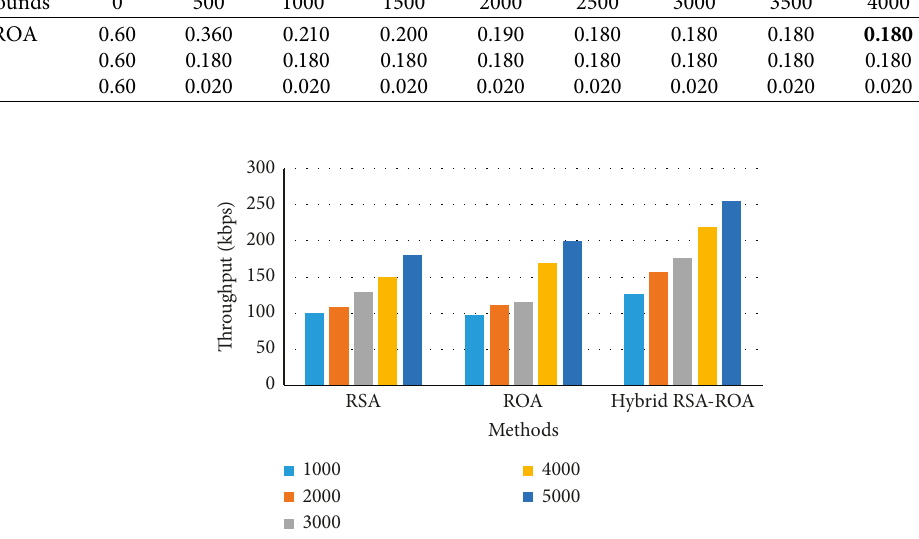
Figure 5: Graphical representation of the proposed method in terms of throughput for network